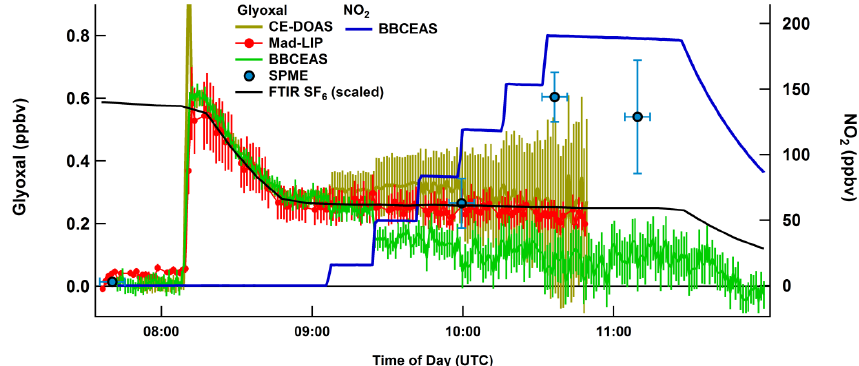
Figure 4. Sensitivity of glyoxal to high levels of NO 2 (experiment E9). Chamber dilution has been scaled relative to concentrations at 08:15UTC from the decay of the SF 6 tracer. See text for details. The error bars are the sum of the statistical uncertainty for retrieving the absorber’s concentration from the spectral structure and the systematic uncertainties in determining the cavity mirrors’ reflectivity, the cavity’s length factor and the uncertainties reported on the literature absorption cross sections used to fit the BBCEAS/CE-DOAS spectra (see Sect. 2.1.4 and in the Supplement).